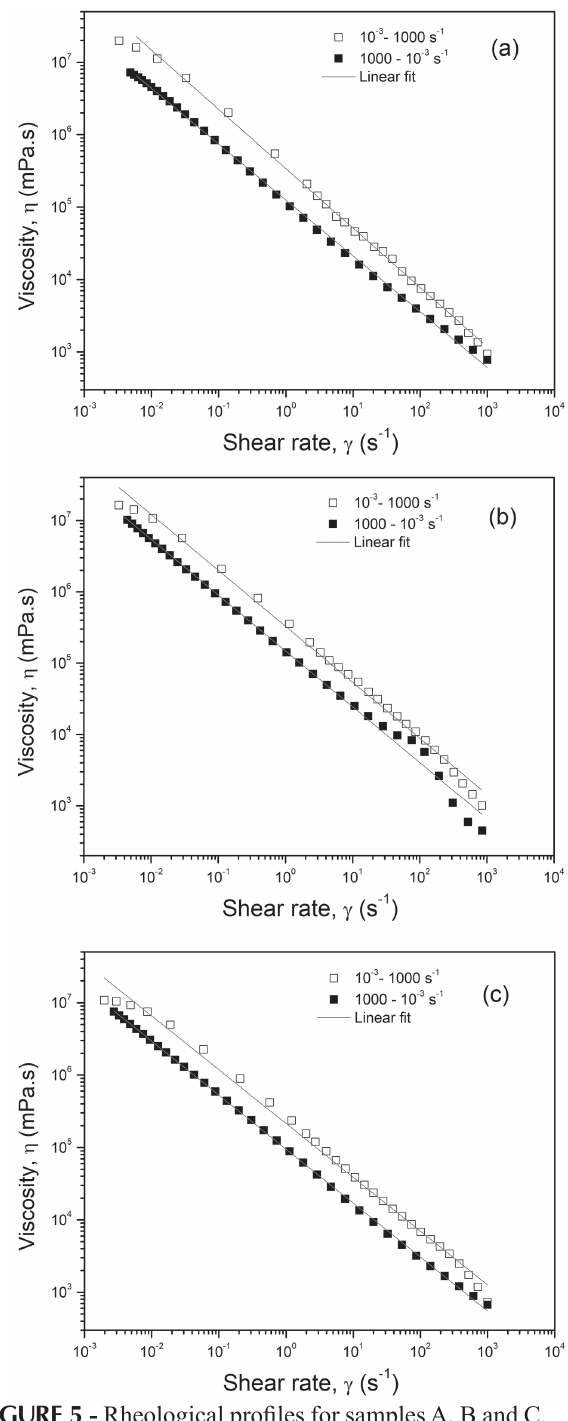
FIGURE 5 - Rheological profiles for samples A, B and